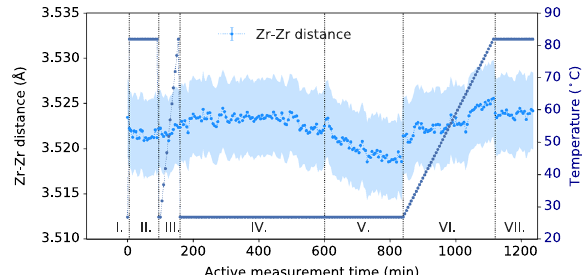
Fig. 8 Zr – Zr nearest neighbor (NN) distances. Distances are averaged over two different fi tting methods. Errors are plotted as the e.s.d. ’ s between the two different re fi nement methods (reference model versus structure re